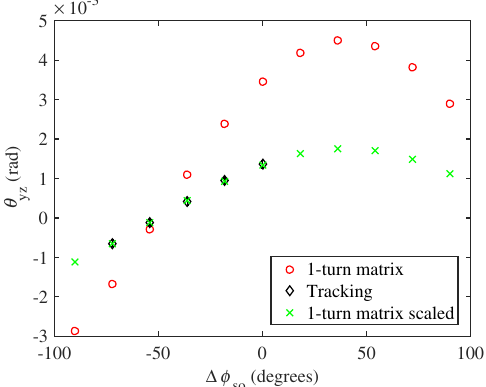
FIG. 3. The yz tilt angle θ yz at the e þ xBSM calculated from the one-turn matrix (red circles and green crosses) for 11 lattices, and from tracking simulations (black diamonds) for five lattices. Δ ϕ is the change of the vertical betatron phase difference between the scraper and the xBSM relative to lat þ ð 0 Þ .